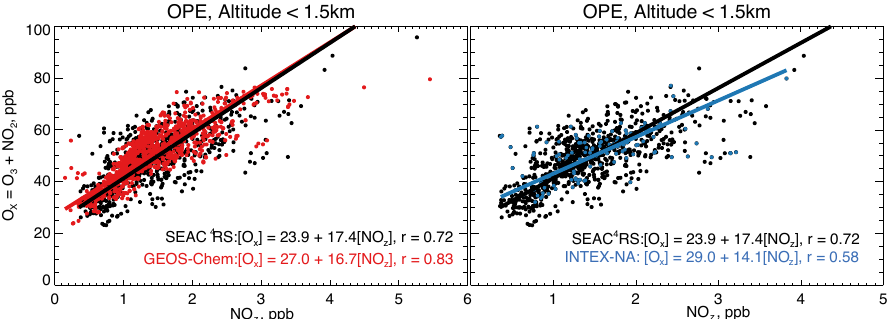
Figure 9. Ozone production efficiency (OPE) over the Southeast US in summer estimated from the relationship between odd oxygen (O x ) and the sum of NO x oxidation products (NO z ) below 1.5km altitude. The left panel compares SEAC 4 RS observations to GEOS-Chem values for August–September 2013 (data from Fig. 2). The right panel compares SEAC 4 RS observations to INTEX-NA aircraft observations collected over the same Southeast US domain in summer 2004 (Singh et al., 2006). NO z is defined here as HNO 3 + aerosol nitrate + PAN + alkyl nitrates, all of which were measured from the SEAC 4 RS and INTEX-NA aircraft. The slope and intercept of the reduced-major-axis (RMA) regression are provided inset with the correlation coefficient ( r ). Observations for INTEX-NA were obtained from ftp://ftp-air.larc.nasa.gov/ pub/INTEXA/.